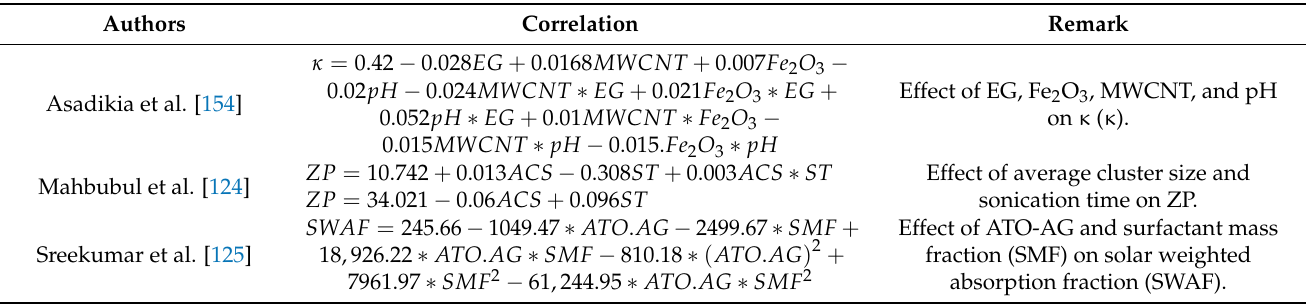
Table 4. Correlations for the estimation of κ , zeta potential, and solar weighted absorption fraction of NFs based on various preparation